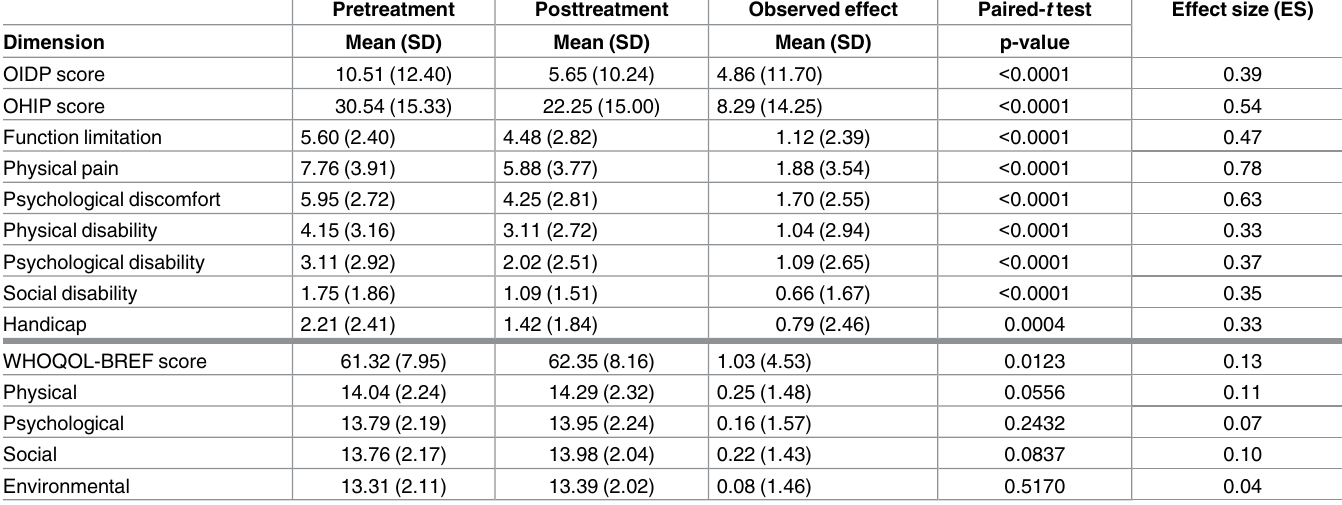
Table 4. Responsiveness of all measurements assessedin 126 subjects with dental caries